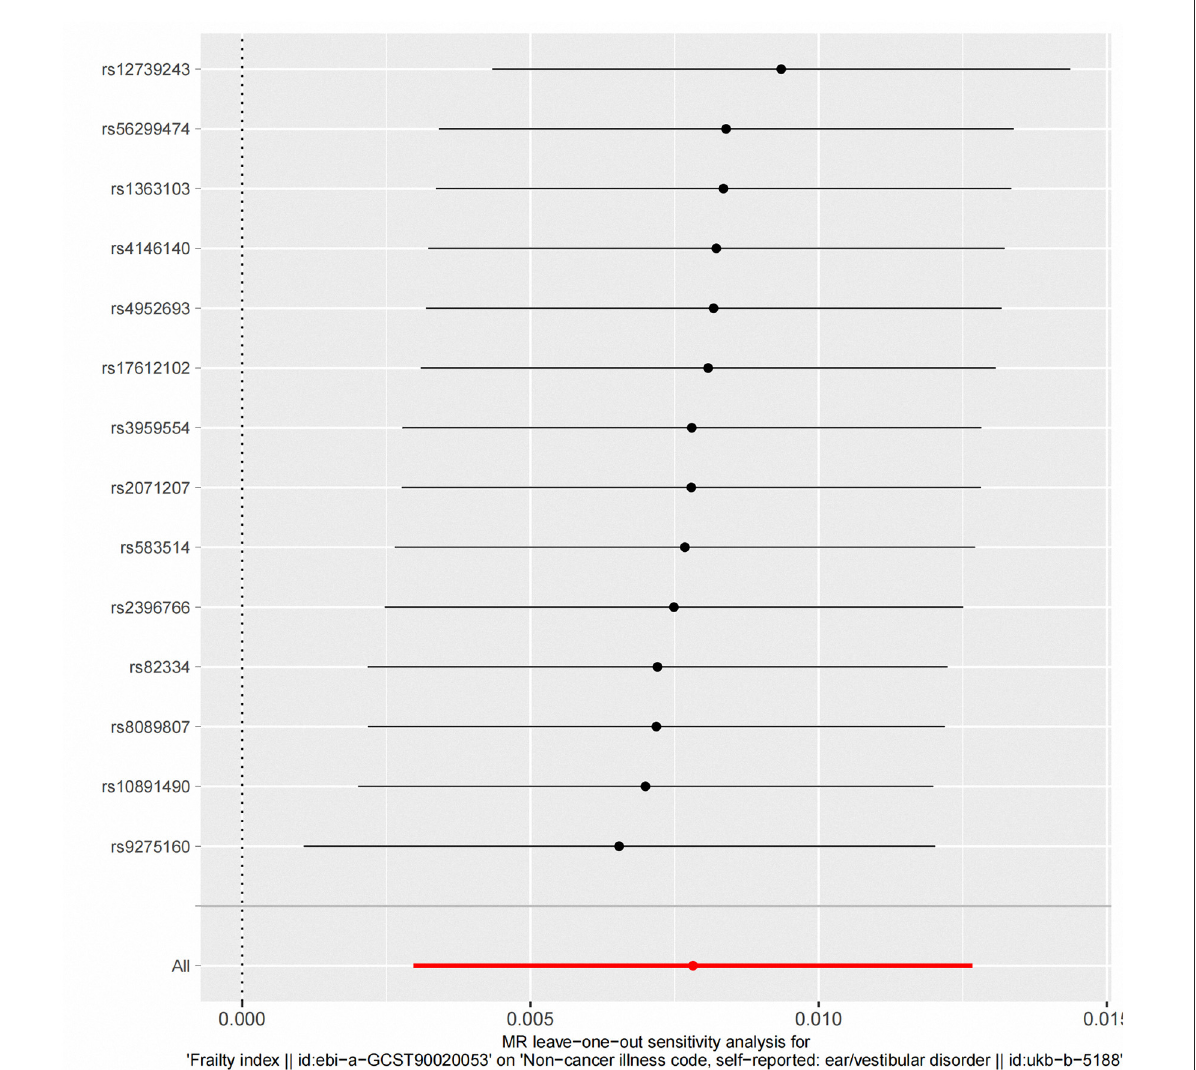
FIGURE4 “Leave-one-out” analysis of the causal association of frailty Index and vestibular disorders. The black dots and bars indicate the causal estimate and 95% CI when an SNP was removed in turn. The red dot and bar indicate the overall estimate and 95% CI using the fixed-effect IVW method; CI, confidence interval; SNP, single nucleotide polymorphism; IVW, inverse-variance weighted.